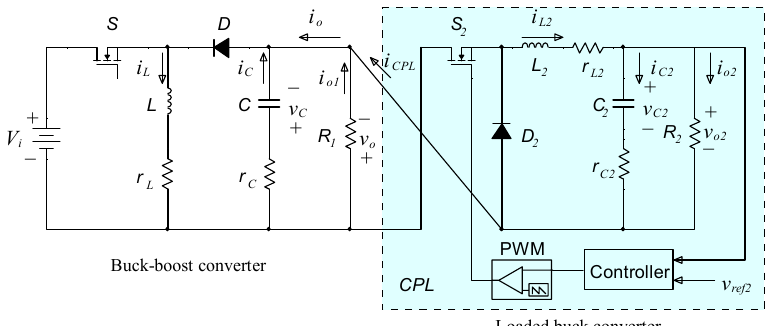
Figure 7. Buck–Boost converter with a pure resistive load and a constant power load (CPL) connected in parallel.